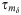
Modelling the effects of Notch signalling on the synchrony of neighbouring cell oscillations.5A: Notch signalling network between neighbouring cells. The light blue section corresponds to the intra-cellular her1/7 feedback loop of Fig 1A. The green section corresponds to Notch inter-cellular signalling. Her1/7 protein inhibits expression of delta in addition to her1/7. Transcription and translation of delta occurs with respective delays τmδ and τpδ. Delta activates Notch in the neighbouring cell and NICD is produced with delay, τpN. When Notch binds to the her1/7 genes this leaves them in an active state, influencing the her1/7 intra-cellular feedback loop. 5B: Competitive binding reaction kinetics of Her1/7 and Notch proteins to the sites on her1/7 DNA. When the her1/7 gene is free or bound to NICD then the gene is active. When Her1/7 binds to the her1/7 gene then expression of the gene is inhibited. It is these reaction kinetics that we model with a modified Gillespie Algorithm. 5C: Plot of oscillating Her1 levels versus time when Notch signalling has been incorporated into the model. The coloured lines correspond to five randomly selected individual cells; the black line corresponds to the mean of all 64 cells. The cells oscillate in synchrony. 5D: The normalised mean population levels of her1 mRNA, her7 mRNA, Her1 protein, Her7 protein, delta mRNA, Delta protein and Notch protein demonstrating the phase of each population. Notch is almost totally out of phase with Her1/7 so will be high when Her1/7 is low and vice versa. 5E:Plots of multiple cells oscillatory clocks versus time (compare to Fig 3). Each lattice is a single cell. Each five minute interval is marked by two columns of 32 cells. The mean phases of oscillation over all cells are marked by the magenta lines. The cells remain in synchrony throughout and generate well defined somites. The modelling demonstrates that Notch signalling is able to override the effects of stochastic gene regulation and keep neighbouring cell clocks oscillating in synchrony.